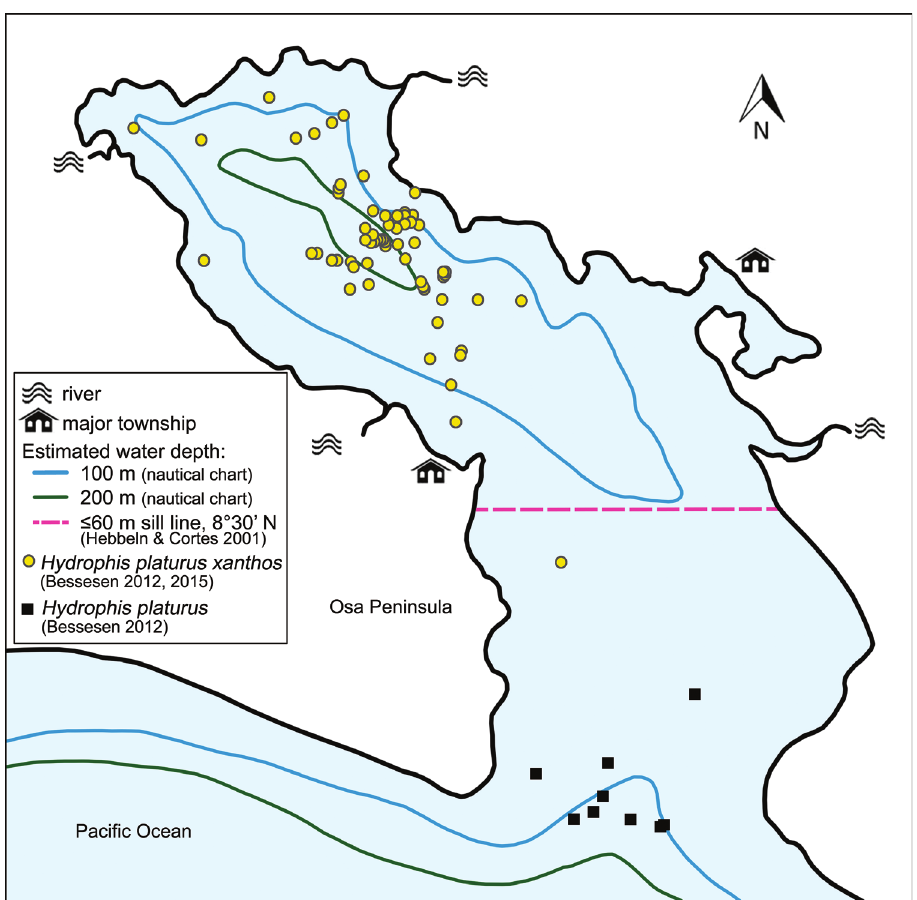
Figure 1. GPS sighting points for all sea snakes observed in Golfo Dulce during the 2010 and 2011 dis- tribution study show Hydrophis platurus xanthos to reside in the inner basin, geographically divided from the broader Eastern Pacific population (Bessesen 2012,